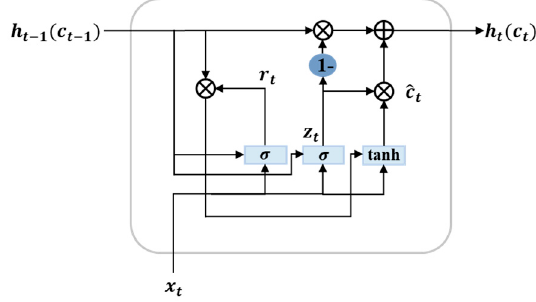
Figure 10. Overall architecture of the GRU network.